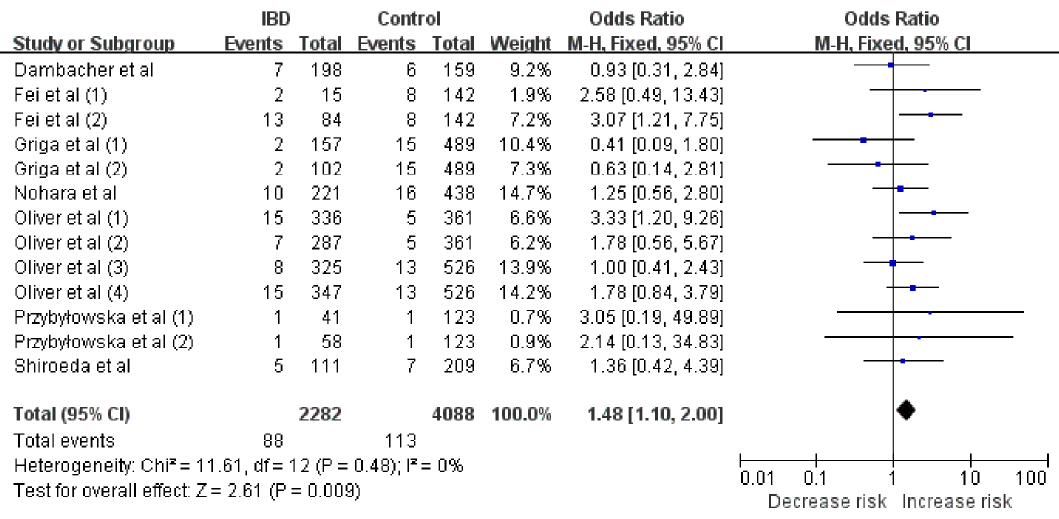
Figure 1. Meta-analysis using a fixed-effects model to evaluate the association between the MIF -173 G/C polymorphism and IBD risk (CC vs . CG + GG). The size of the square is proportional to the weight of each study; horizontal lines represent the 95% CI.